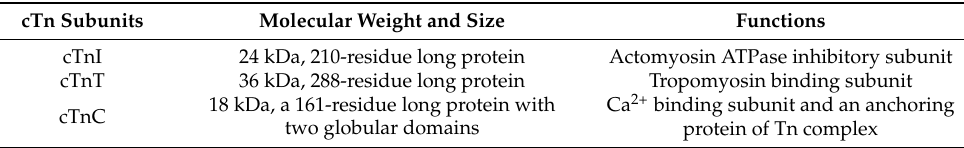
Table 1. Cardiac Troponin (cTn) subunits/role